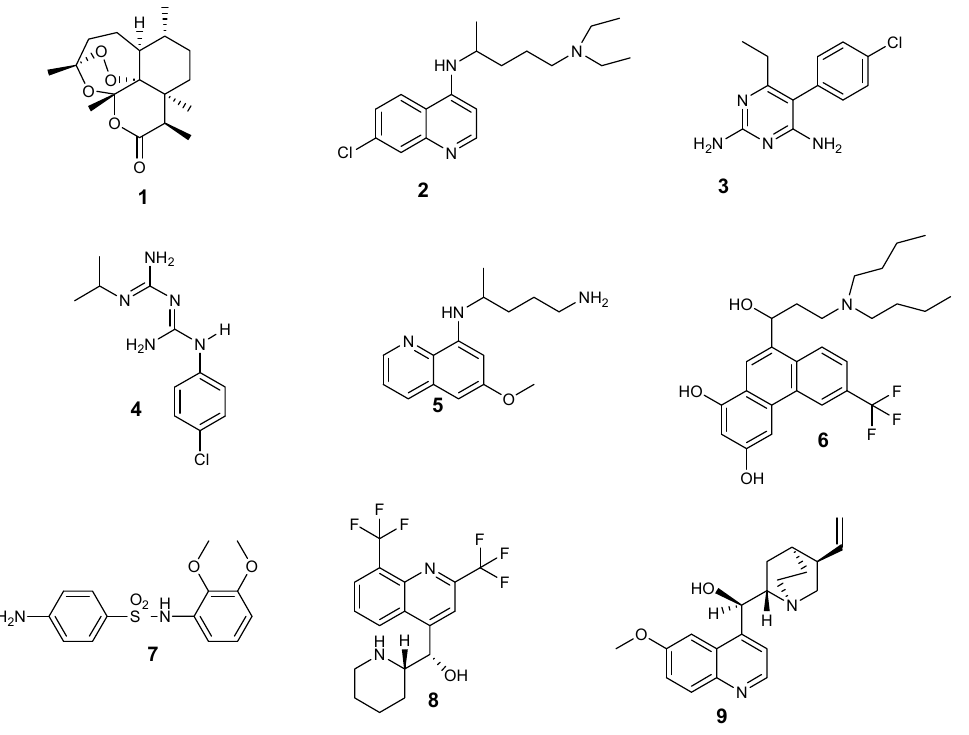
Figure 1. Structures of some antimalarial drugs.